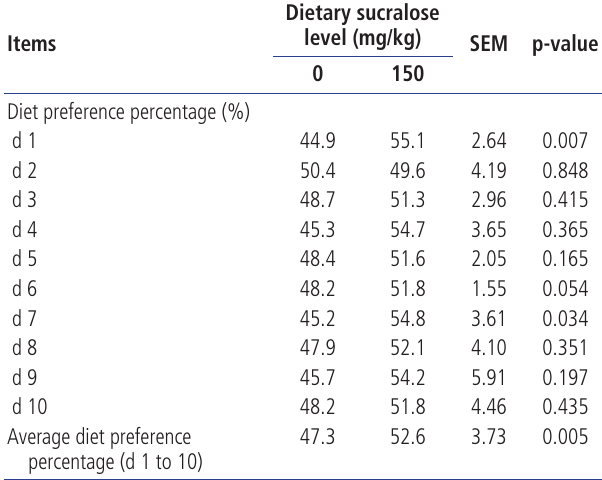
Table 2. The effects of dietary sucralose on diet preference of weaned piglets (experiment 1)